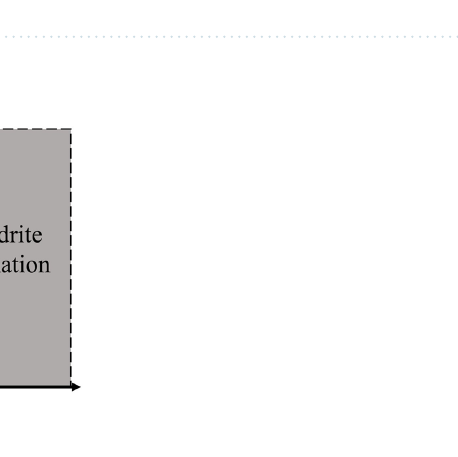
Figure 13. Regime diagram according to Péclet and Damköhler